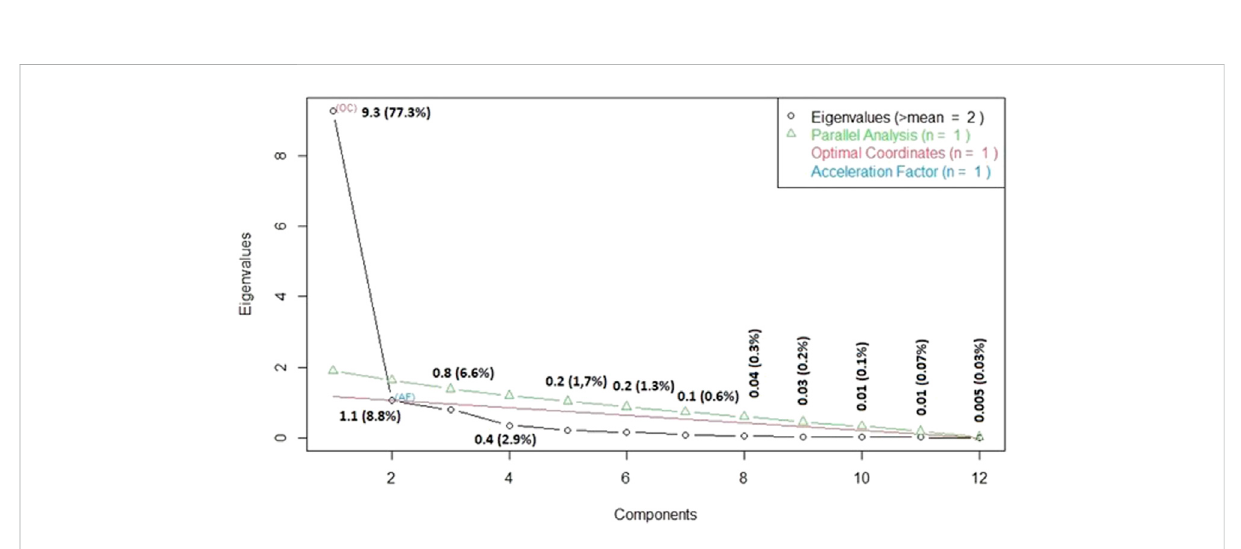
FIGURE 8 Scree plot for PM 10 data matrix obtained by PCA analysis.